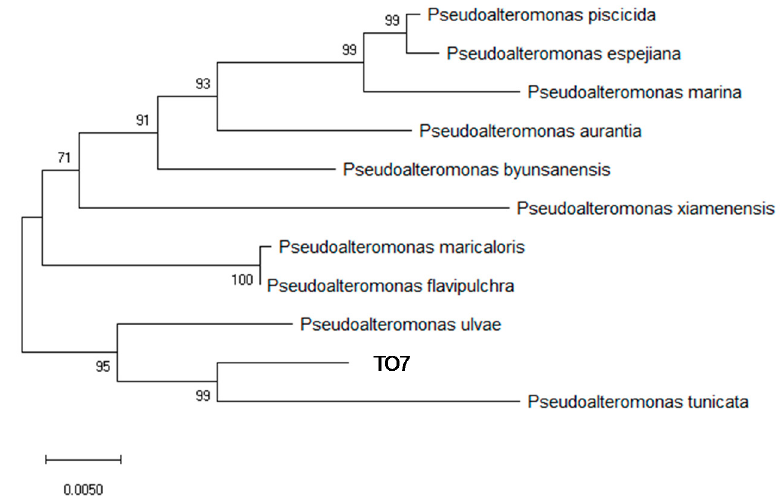
Figure 8. Phylogenetic tree of TO7 using 16S rRNA sequences. TO7 was identified as Pseudoalteromonas sp. (Accession numbers are in Table S6).